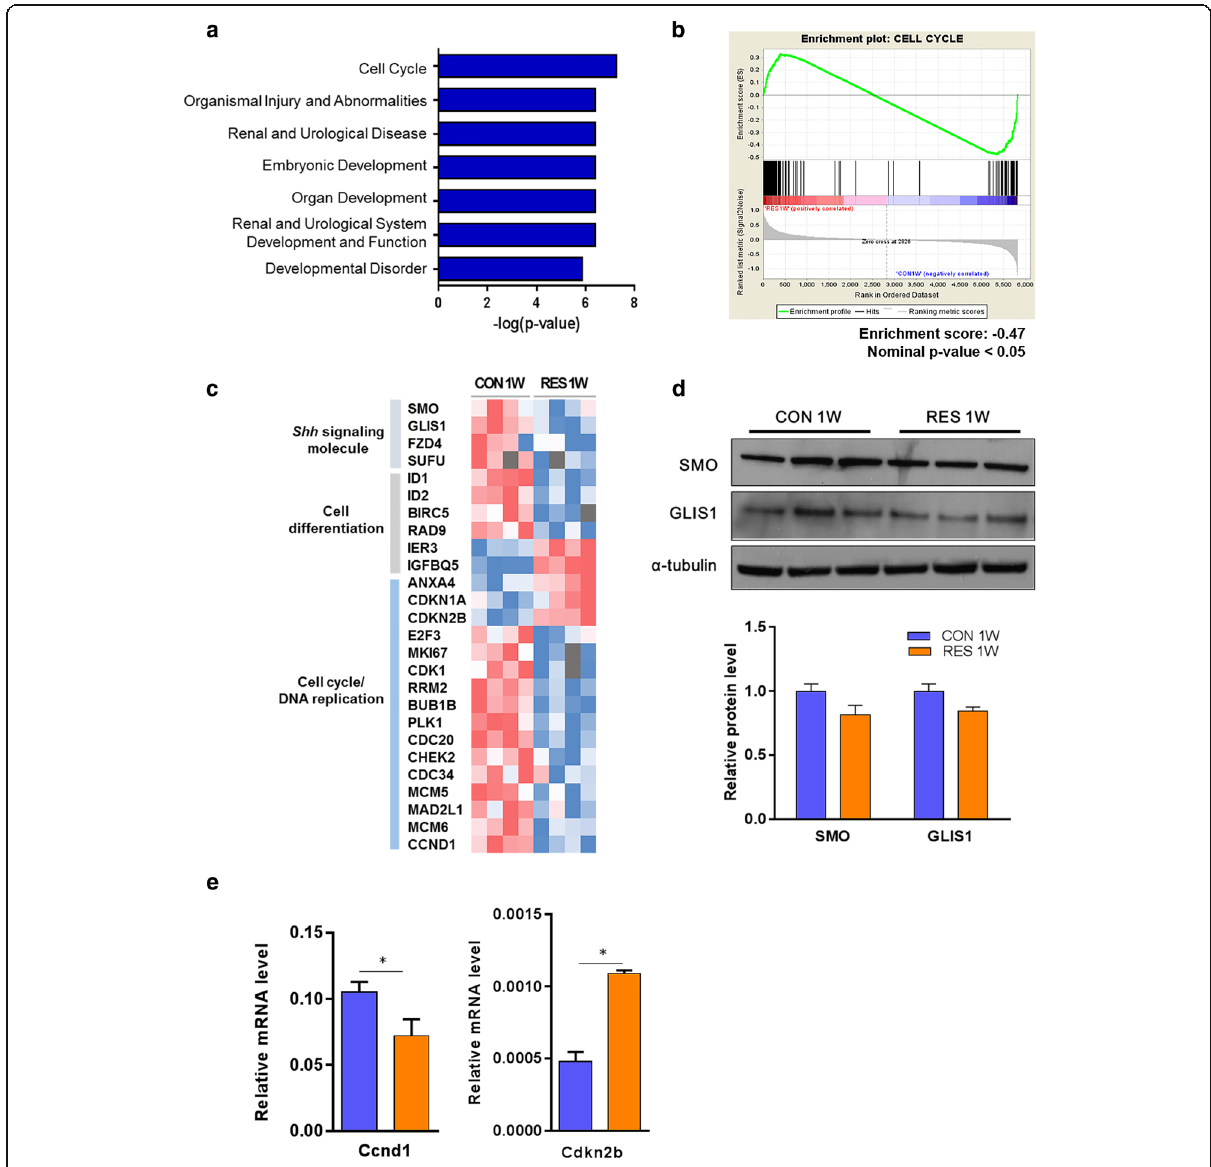
Fig. 4 Dehydration interrupted renal morphogenesis by regulating Shh signaling in infant mice. a Top disease and functional categories of gene sets among differentially expressed genes in dehydrated mice during infancy. b Gene set enrichment analysis (GSEA) was used to evaluate the most significant functional category of differentially expressed genes by dehydration in infant mice and generate enrichment plot of cell cycle- related genes. c The heatmap shows downstream target genes of the SHH signaling pathway and indicates that cell cycle and cell differentiation regulators were distinctively regulated by dehydration. d Western blot assay was conducted for SHH signaling members. e The transcript level of its target molecules was validated with qPCR analysis. Data are expressed as mean ± SEM. Student ’ s t test; * p < 0.05 versus control